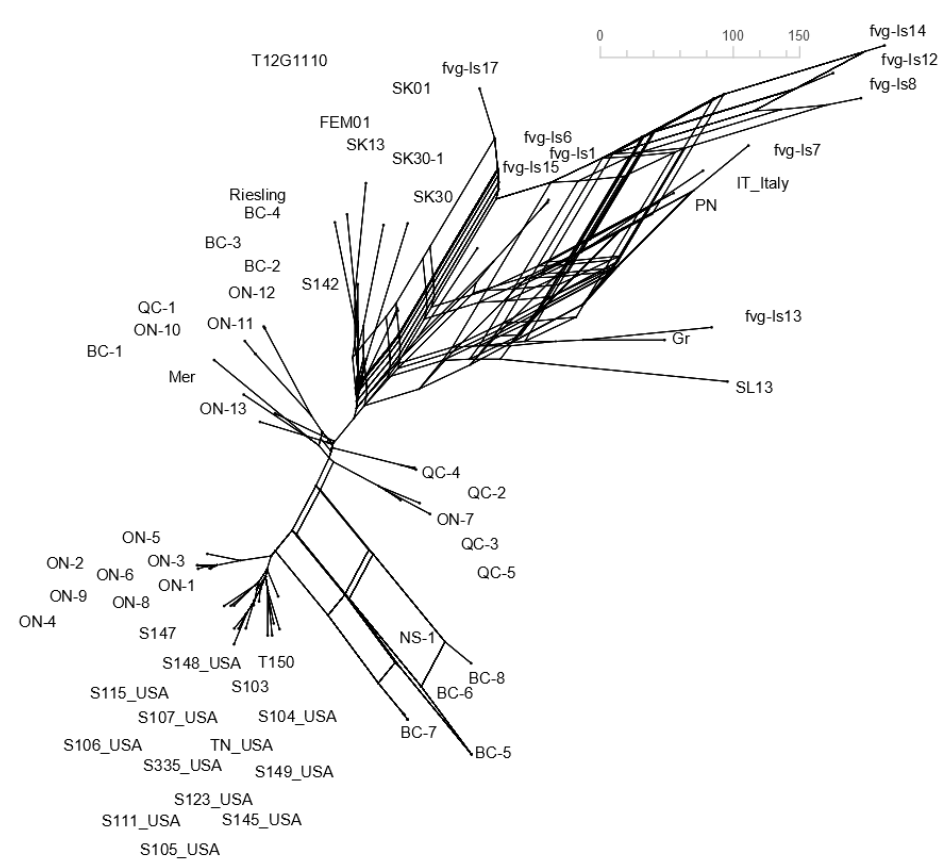
Figure 2. Consensus network built from three ML trees of larger recombination-free segments. The Consensus Network method (Holland and Moulton 2003) and the Splits Network algorithm method (Dress and Huson 2004) was used with default options and accepting threshold of 0.33 (Splittree 5.3.0). ML tree for the largest segment (4866 bp) is shown in Figure S2.